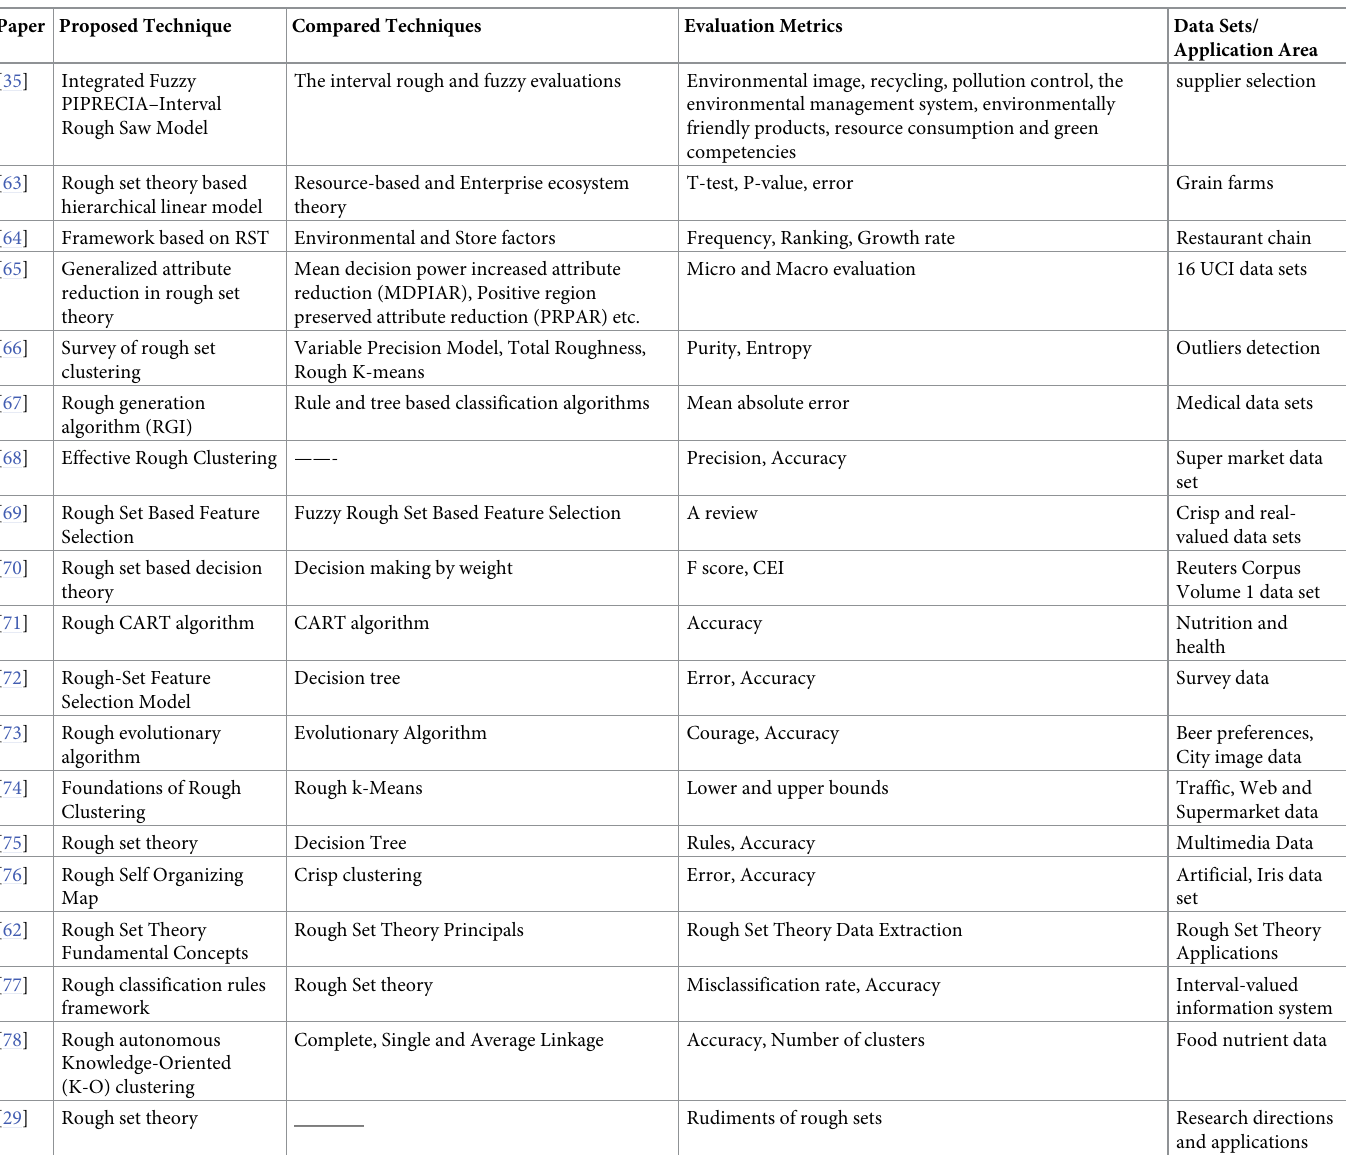
Table 2. Summary of related work on rough set